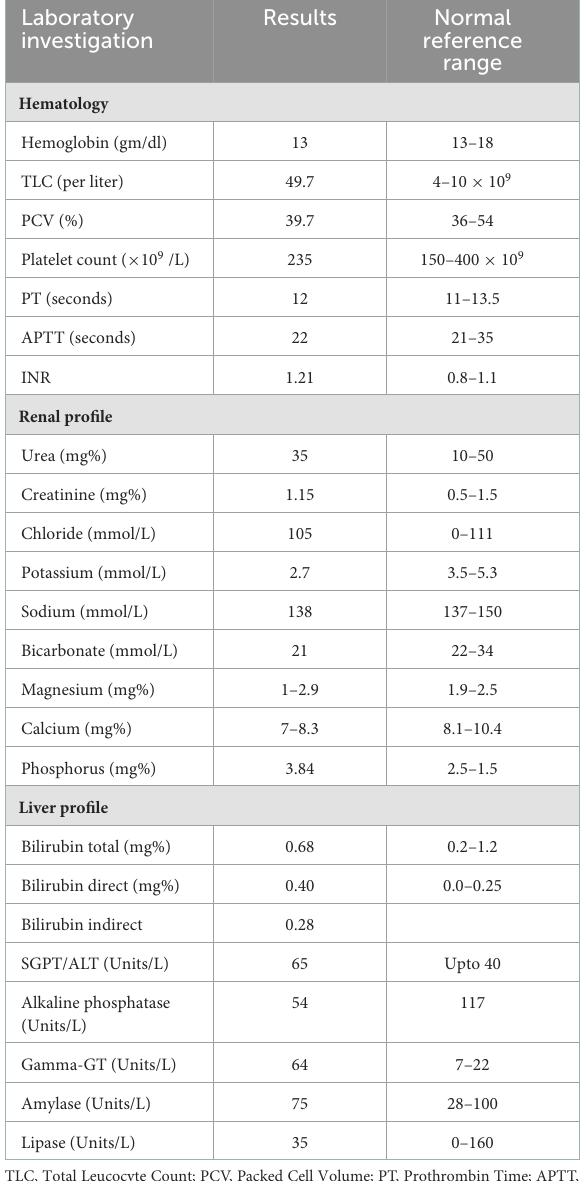
TABLE 1 Results of laboratory